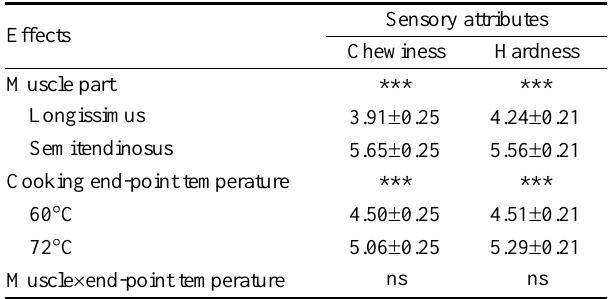
Table 2. Effects of muscle part and cooking end-point temperature on sensory ratings defined in ISO11036:1994